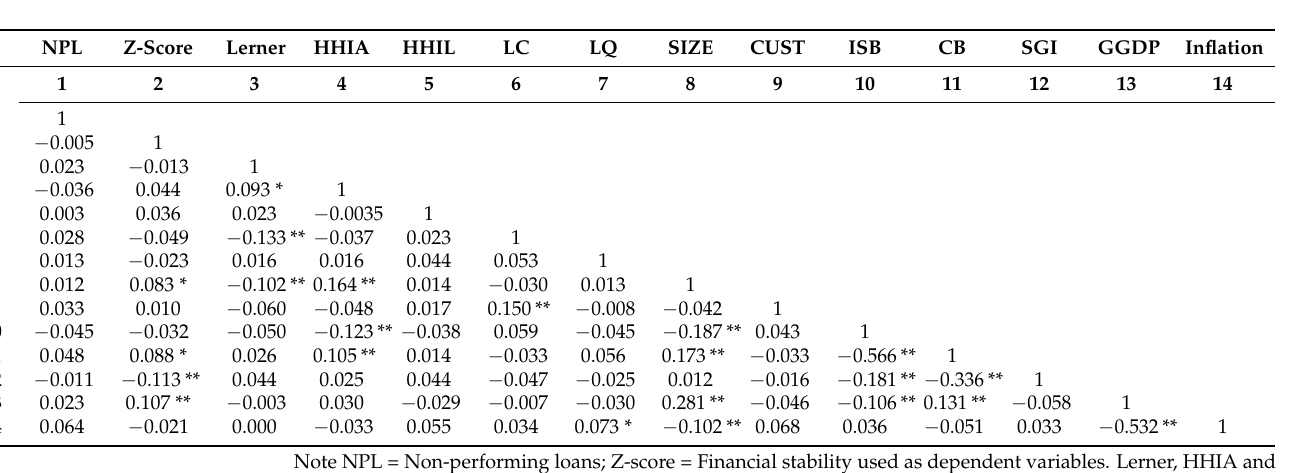
Table 3. Correlations.